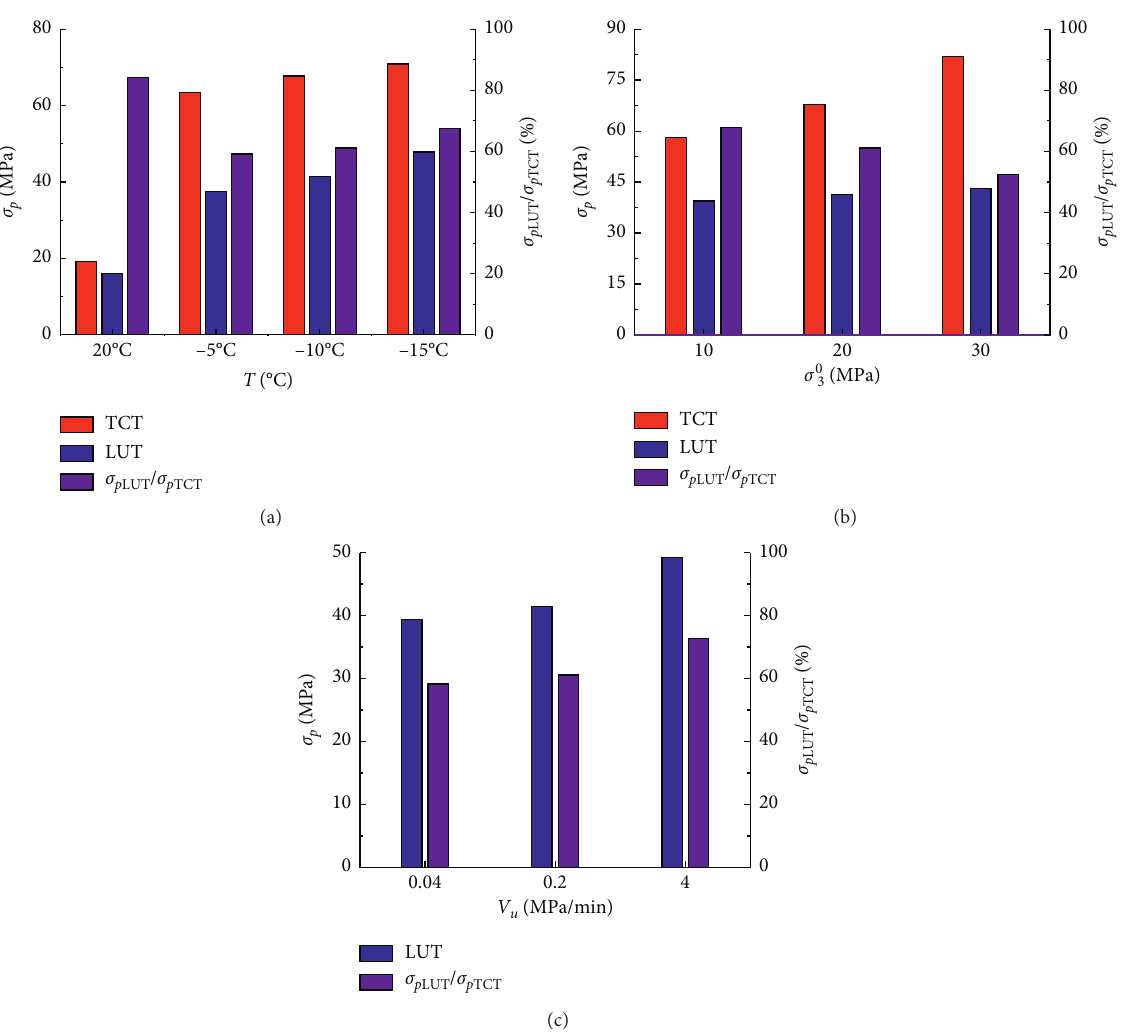
Figure 13: Comparison of peak stress of lateral unloading and peak stress of triaxial compression ( σ stress of lateral unloading to the peak stress of triaxial compression). (a) Different temperature. (b) Different confining pressure. (c) Differentlateral unloading